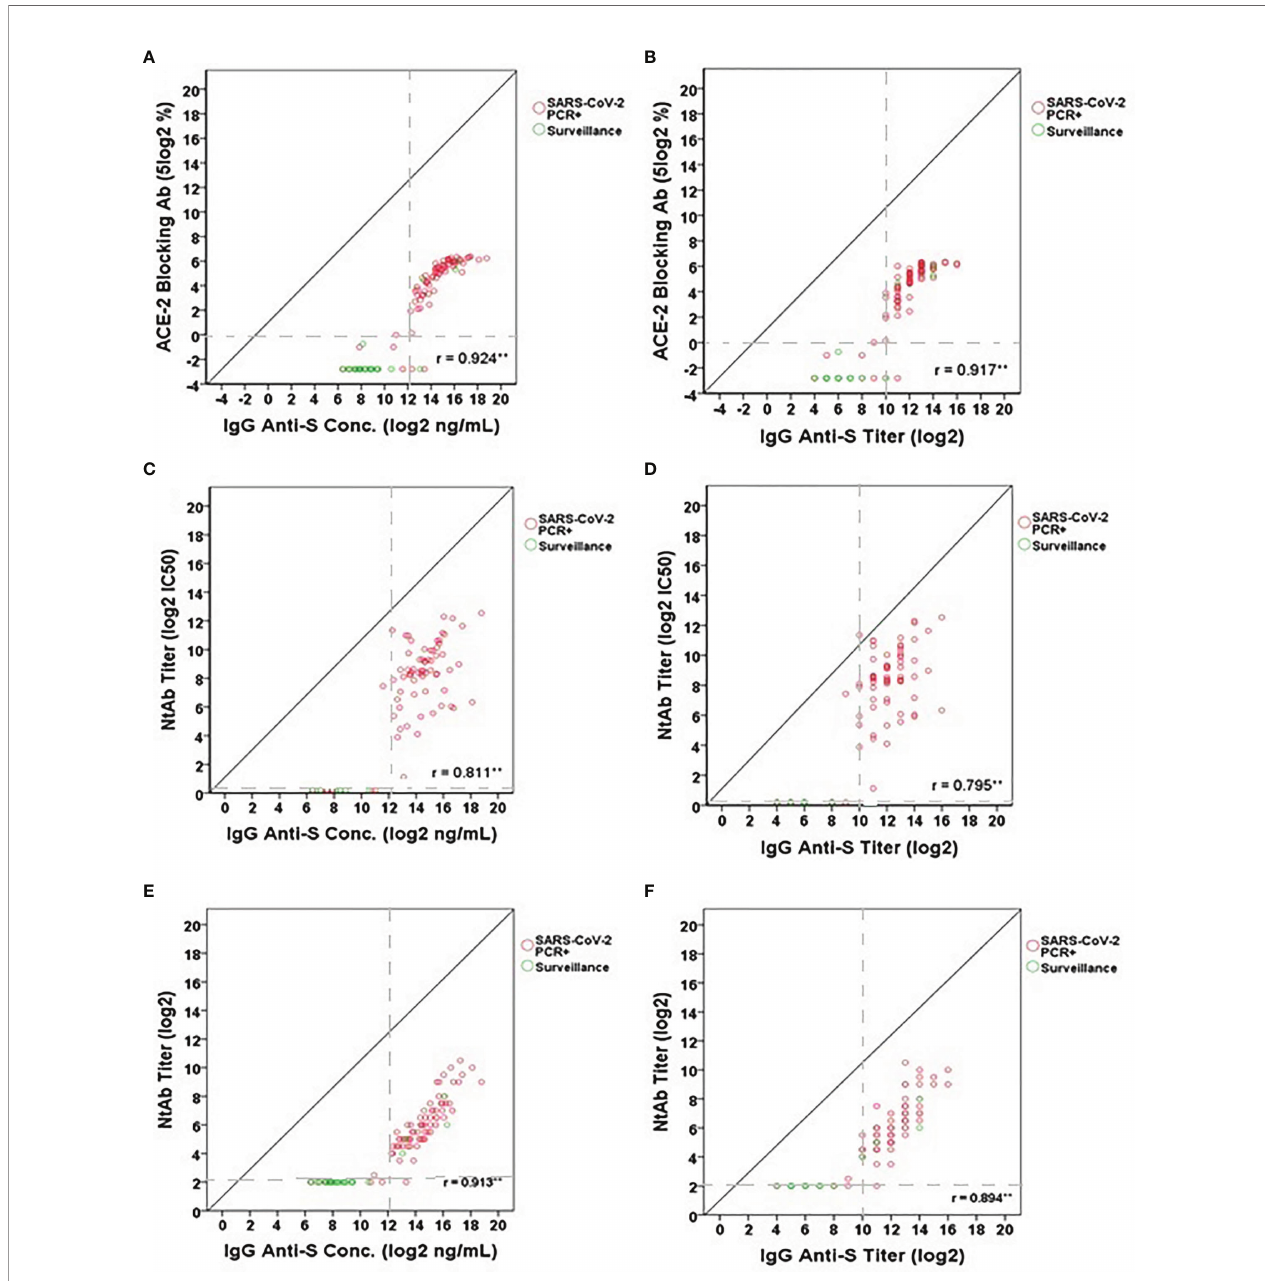
FIGURE 4 | Correlation between IgG anti-S levels and (A, B) ACE-2 receptor blocking antibody levels (5 log2%), (C, D) lentipseudovirus-S neutralizing antibody titers (log2 IC 50 ) and (E, F) SARS-CoV-2 neutralizing antibody titers (log2). A total of 101 serum samples including 76 SARS-CoV-2 PCR positive sera and 25 SARS- CoV-2 surveillance sera were tested in the IgG anti-S ELISA, ACE-2 receptor blocking antibody assay, and SARS-CoV-2 microneutralization assay. A total of 79 serum samples (73 SARS-CoV-2 PCR positive sera and 6 SARS-CoV-2 surveillance sera) were tested in the lentipseudovirus-S neutralizing antibody assay. SARS- CoV-2 PCR positive sera represented by red open circles and SARS-CoV-2 surveillance sera by green open circles. Gray dash lines represent the cut-offs of antibody titers (log2) or concentrations (log2 ng/mL). Pearson ’ s correlation coef fi cient was calculated to measure the strength of the linear association. *Correlation was signi fi cant at the 0.05 level (2-tailed). **Correlation was signi fi cant at the 0.01 level